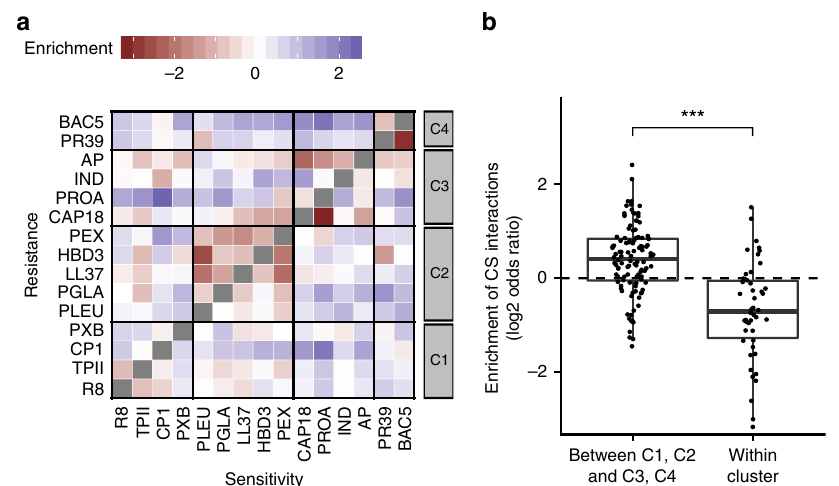
Fig. 4 Collateral sensitivity (CS) interactions are frequent between AMPs with different modes of action. a Heatmap depicting the overrepresentation of collateral sensitivity-enhancing genes for each AMP pair over random expectation ( n = 210 AMP pairs). Random expectation is calculated using the number of resistance-enhancing genes and sensitivity-enhancing genes for each AMP (see Methods). b Collateral sensitivity effects were especially pronounced between AMP pairs with different broad mode of action, that is, between membrane-targeting (C1, C2) and intracellular-targeting (C3, C4), as compared to AMP pairs from the same cluster. Signi fi cant difference: *** P = 1.7 × 10 − 08 from two-tailed unpaired t -test, n = 108 and 46 for pairs of AMPs between C1, C2, and C3, C4, and those within cluster, respectively. Y -axis shows odds ratio (log2) of enrichment of collateral sensitivity interactions between AMP pairs. Boxplots show the median (center horizontal line), the fi rst and third quartiles (bottom and top of box, respectively), with whiskers showing either the maximum (minimum) value or 1.5 times the interquartile range of the data. Source data are provided as a Source Data fi (Fig. 5b) and an increased membrane potential (Fig. 5c and Supplementary Fig. 16).